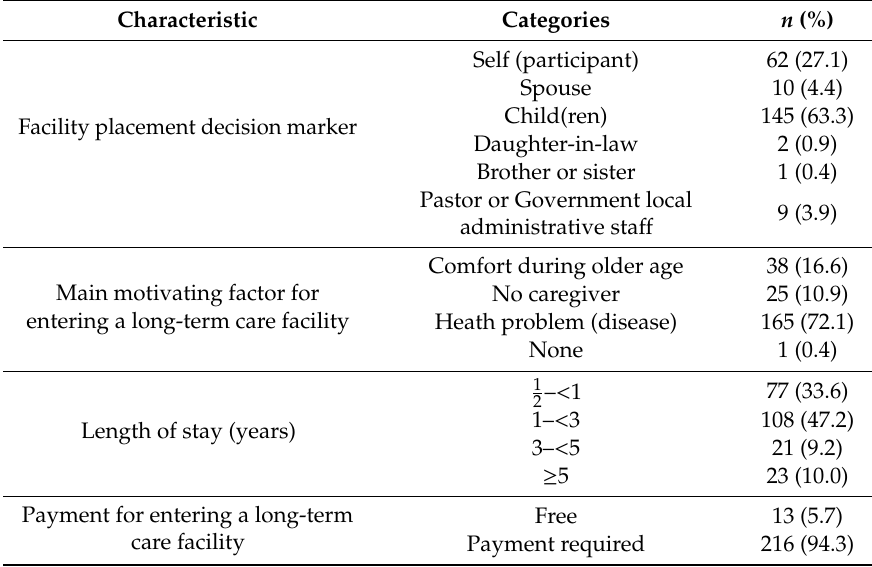
Table 2. Characteristics related to entering a long-term care facility ( n =